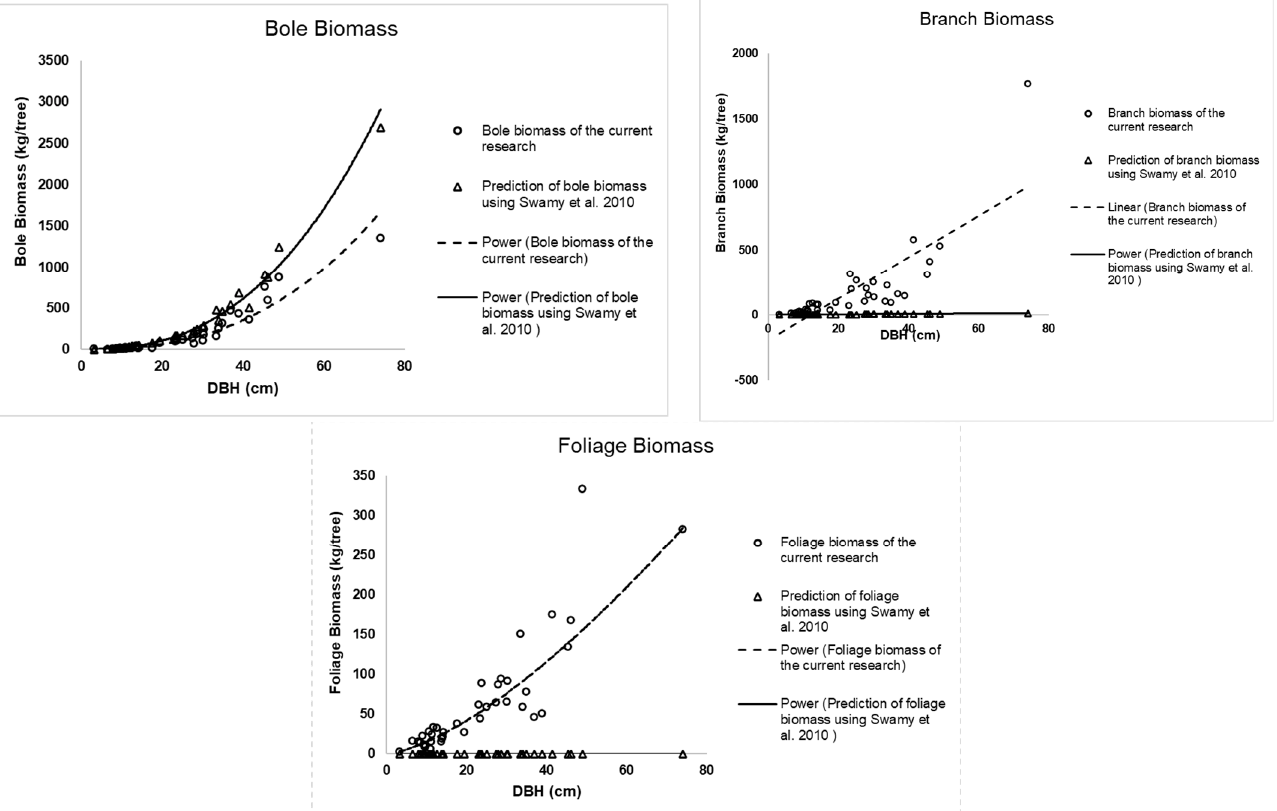
Figure 3. Comparison of the measured biomass of the current study and the predicted biomass using the allometric equations of Swamy et al. [35].